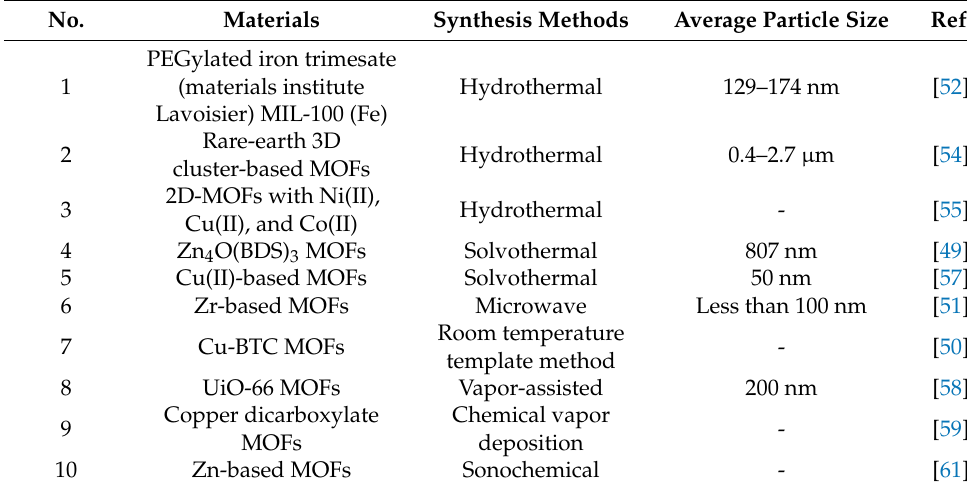
Table 1. Synthesis of MOF materials using various methods.